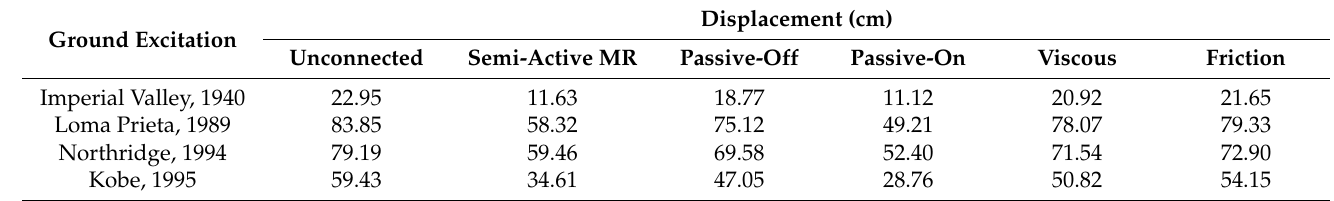
Table 7. Comparison of top storey peak displacement of the coupled flexible building under different control strategies when dampers are arranged in Configuration